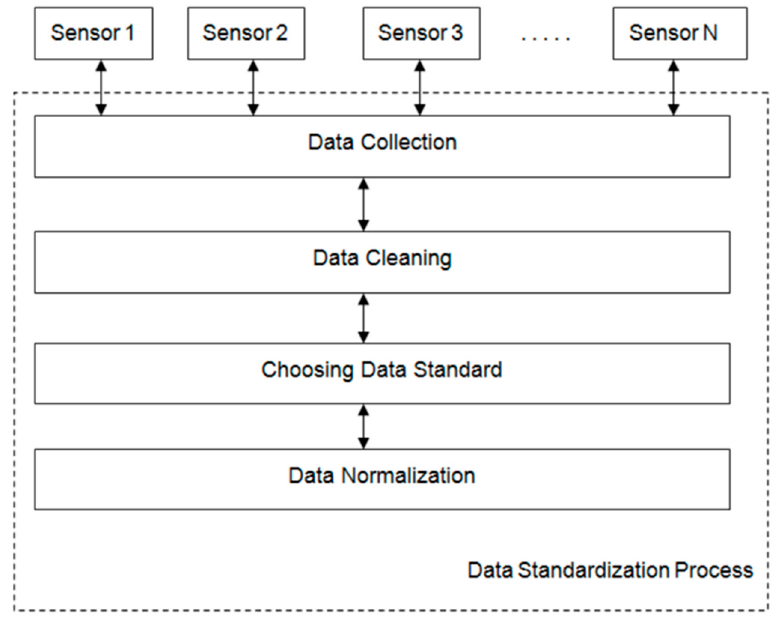
Figure 2. Data standardization